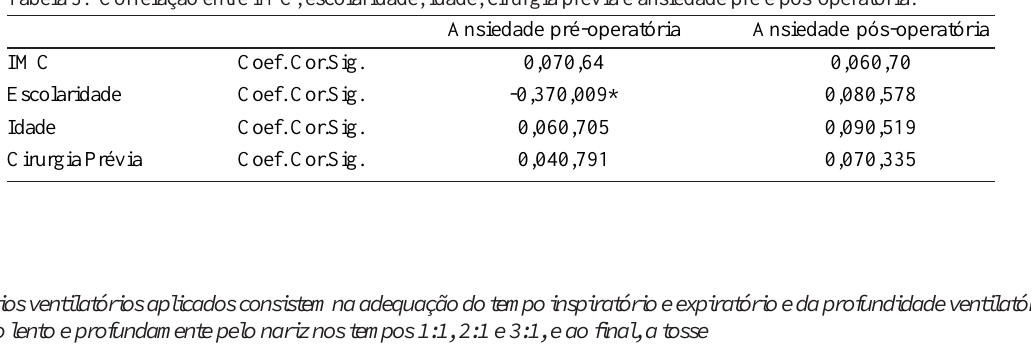
** Os exercícios ventilatórios aplicados consistem na adequação do tempo inspiratório e expiratório e da profundidade ventilatória, sendo o ar inspirado lento e profundamente pelo nariz nos tempos 1:1, 2:1 e 3:1, e ao final, a